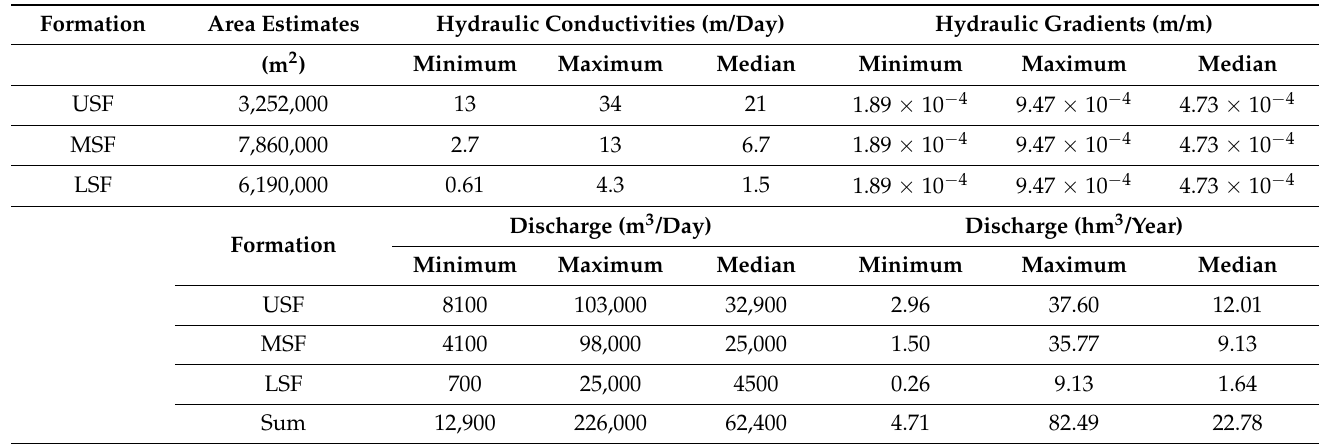
Table 1. Values used in groundwater throughflow estimates between the Conejos-M é danos portion of the Mesilla/Conejos M é danos Basin (Basin), moving north to the Mesilla portion of the Basin. Area estimates are determined from cross-section K-K’ by Hawley and Kennedy (2004) [8], hydraulic conductivities are reported values from Frenzel and Kaehler (1992) [14], and hydraulic gradients are estimated from Figure 5. [m 2 , square meters; m/day, meters per day; m/m, meters per meter; m 3 /day, cubic meters per day; hm 3 /yr, cubic hectometers per year; USF, upper Santa Fe unit; MSF, middle Santa Fe unit; LSF, lower Santa Fe